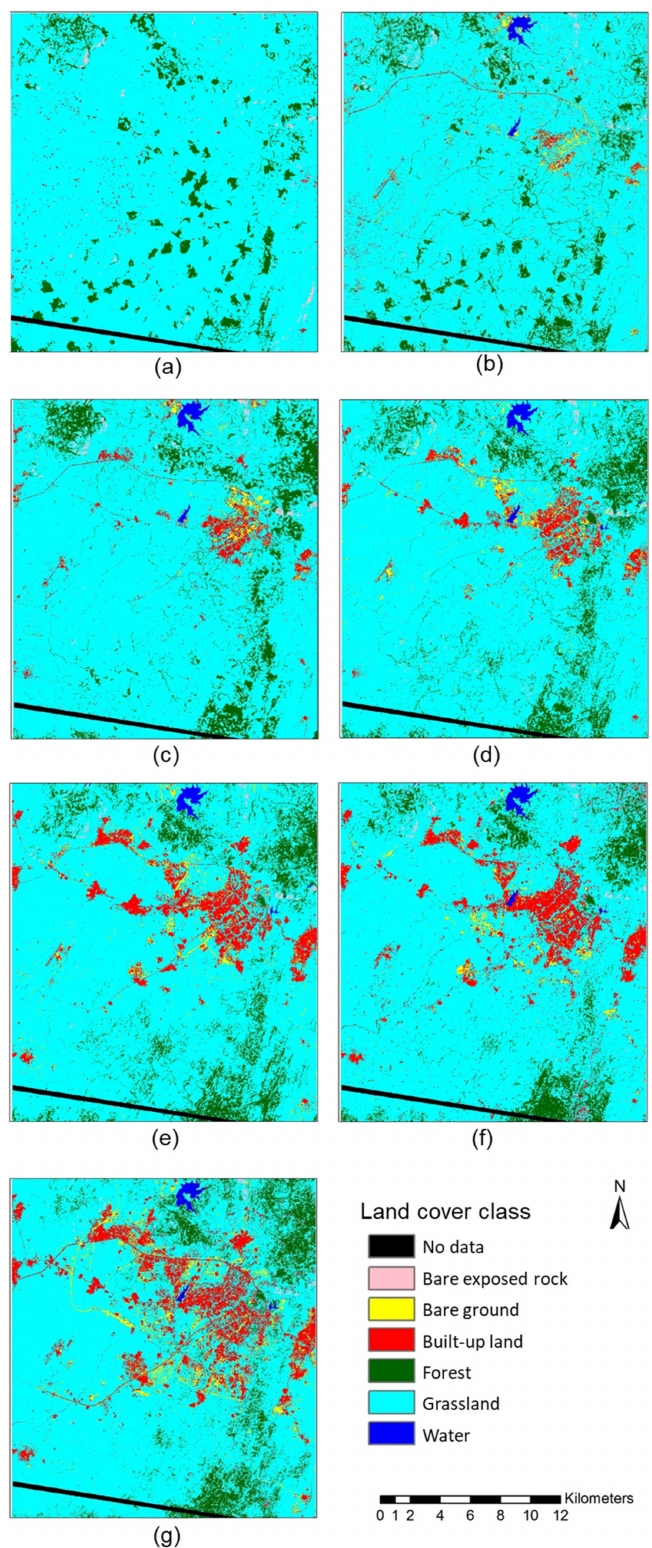
Figure 3. Land cover classification of Abuja, Nigeria and its environs in ( a ) December 1975, ( b ) January 1986, ( c ) February 1990, ( d ) January 1999, ( e ) December 2002, ( f ) January 2008 and ( g ) January 2014. No data corresponds to dropped lines in the 1975 image, with the a ff ected area masked out of all classifications to enable direct